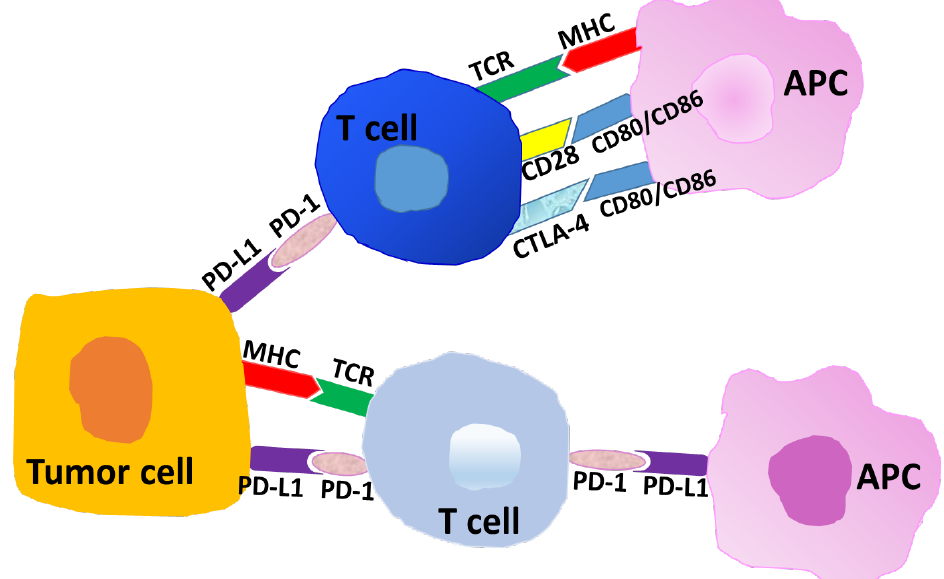
Figure 1. Representative schema of interactions at immune checkpoints. Tumor-associated antigens or neo-antigens are presented by the major histocompatibility complex (MHC) to T cells (T-cell receptor, TCR). The binding of CD28 on T cells to CD80/CD86 (B7-1/B7-2) on antigen-presenting cells (APC) results in heightened immune responses or anti-tumor immunity. The cross-linking of cytotoxic T lymphocyte associated protein-4 (CTLA-4) on T cells to CD80/CD86 on APC results in an inhibition of T cell responses. Programmed death-1 (PD-1) on T cells co-ligating with PD-L1 on APC or on tumor cells results in inhibitory or immune-suppressive responses in the tumor microenvironment.